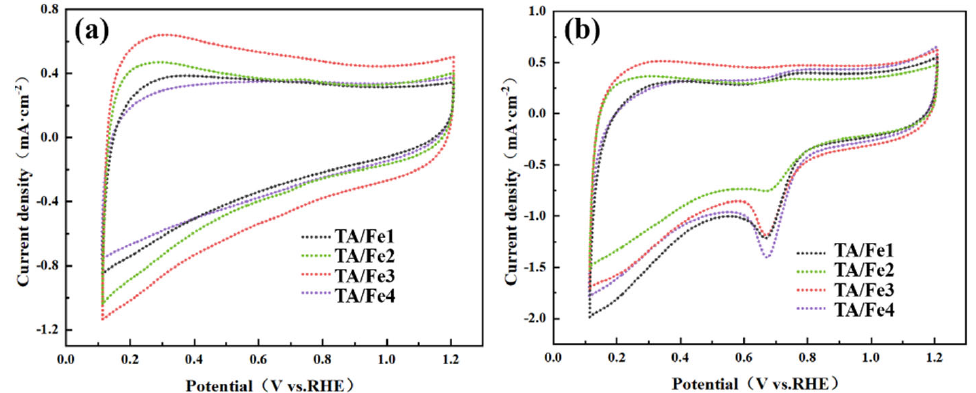
Figure 8. CV curves of the titanium oxide-based aerogel catalysts doped by different Fe sources: ( a ) N 2